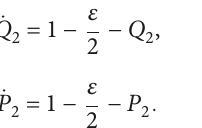
Figure 2: The payo ff matrices of Cases 1 – 4.